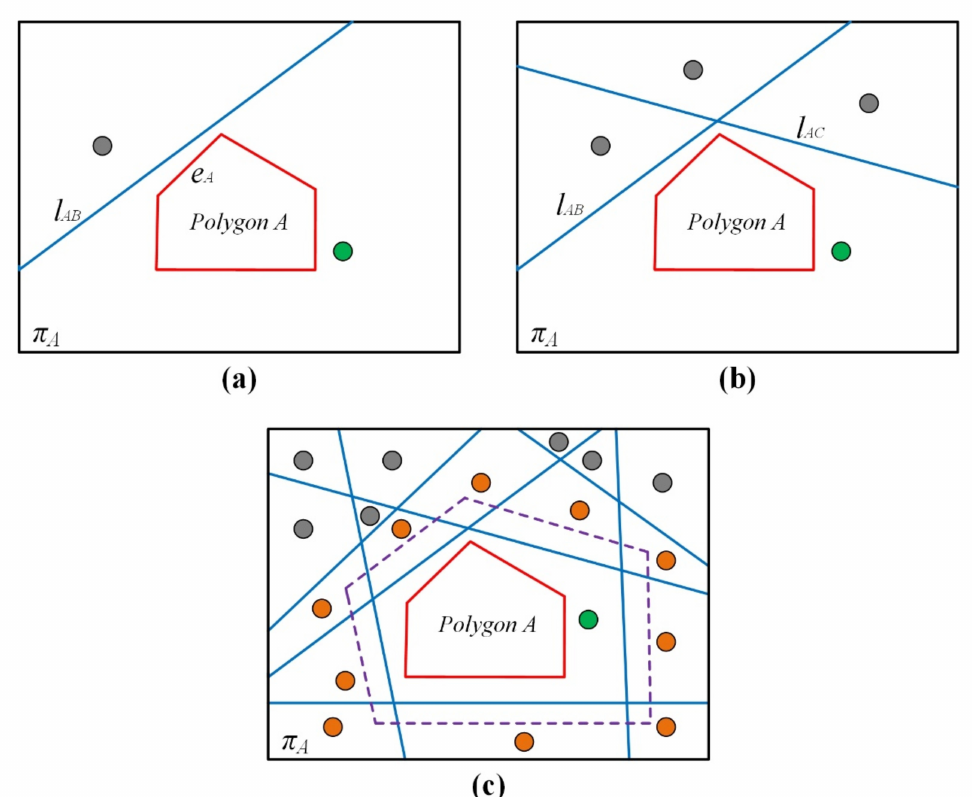
Figure 5. Illustration of the three constraints used to reduce the number of candidate faces. ( a ): Pairwise Constraint; ( b ): Triplet Constraint; ( c ): Nearby Constraint. The red lines depict a simplified boundary polygon A in its supporting plane π A , and the blue lines which separate the plane into several candidate faces are the intersection of other planes in this plane. The green, orange, and gray solid circles indicate the status of the occupied faces as Cover, Near, and Invalid,